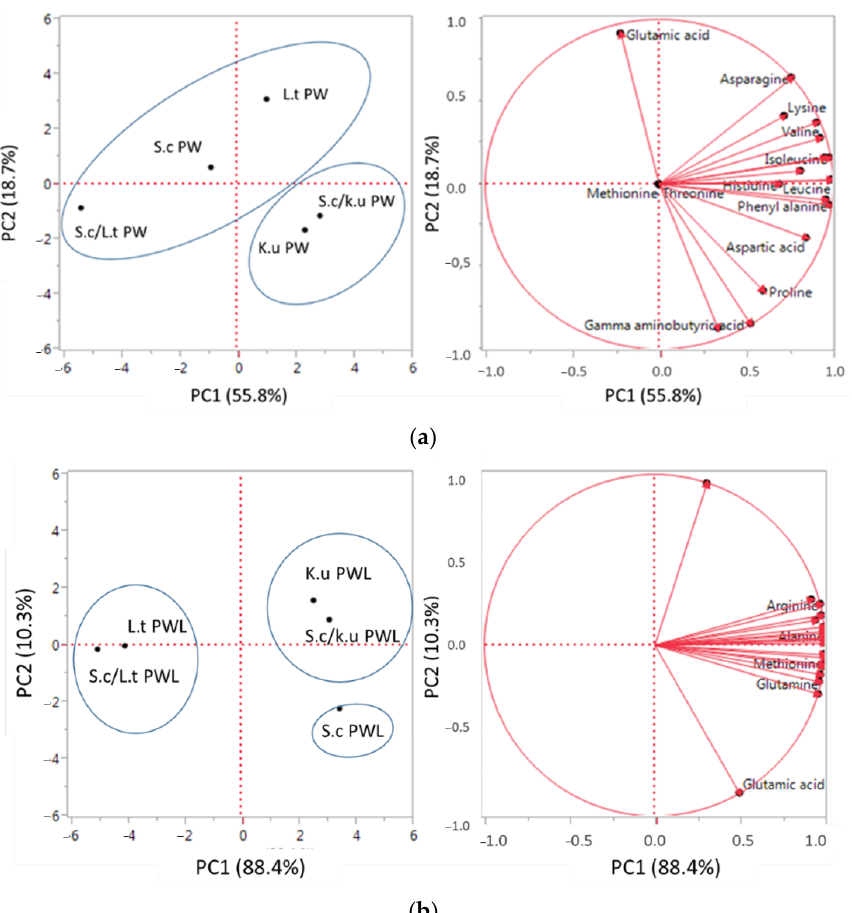
Figure 2. Principal component analysis of amino acid content of final beers. ( a ) Pils wort (PW): the variance explained by principal component analysis (PCA) analysis is PC 1 55.8% X-axis and PC 2 18.7% Y-axis. ( b ) Pils wort + lentil (PWL): the variance explained by principal component analysis (PCA) analysis is PC 1 88.4% X-axis and PC 2 10.3% Y-axis.